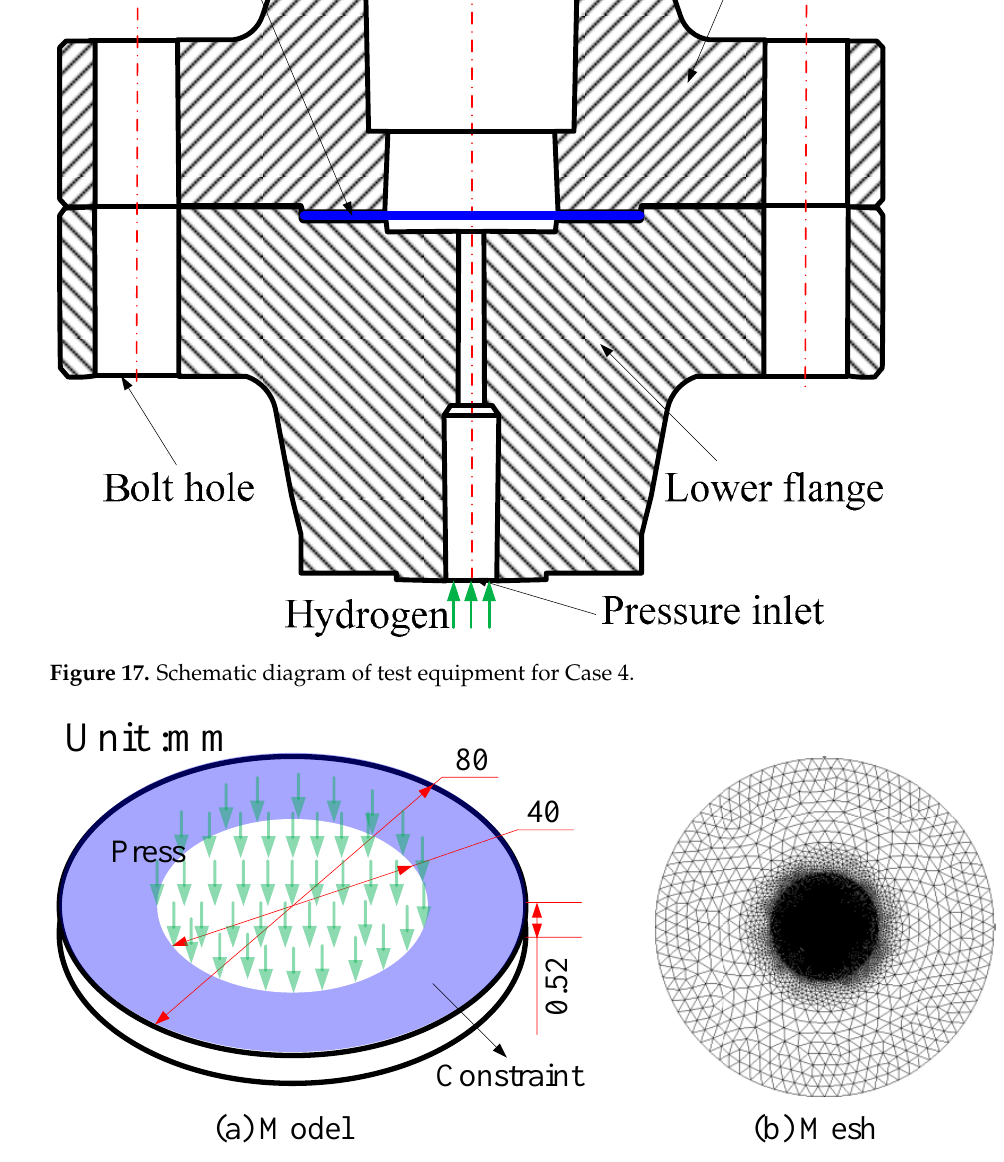
Figure 18. Model and mesh in Case 4. Table 3. Comparison between simulation and test for Case